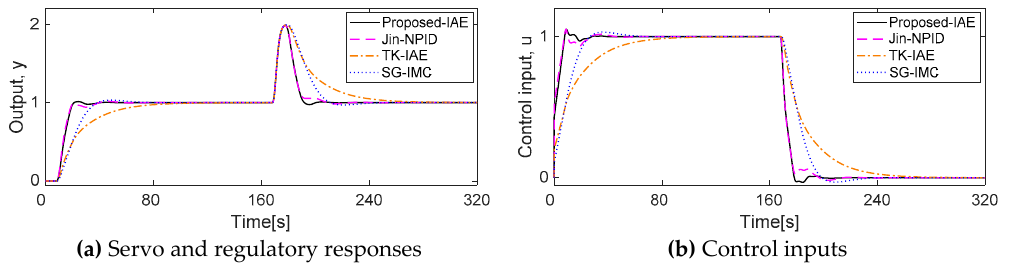
Figure 13. Servo and regulatory responses for nominal process 4.